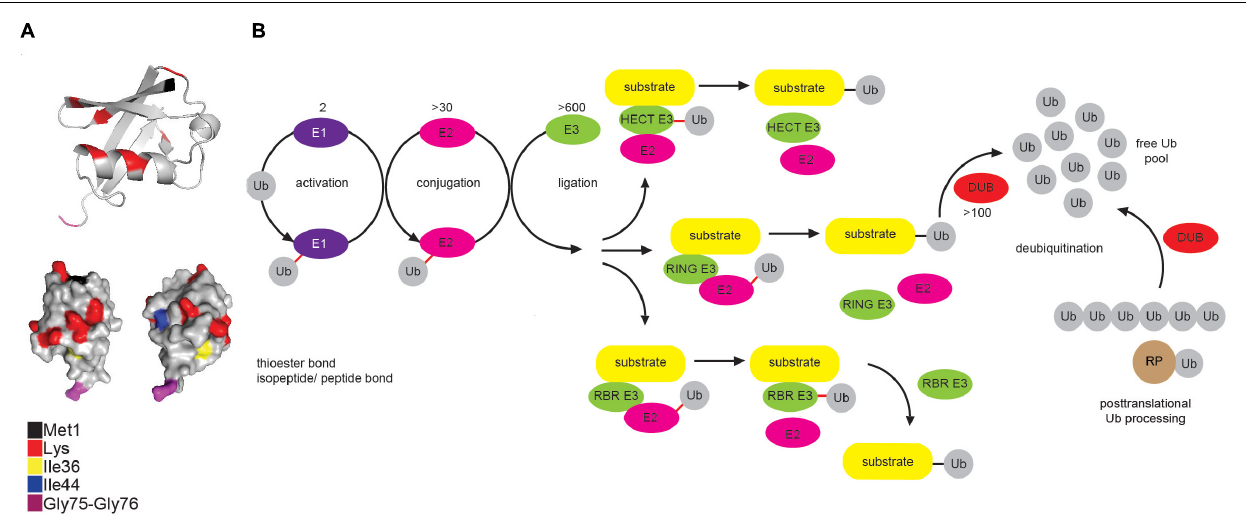
FIGURE 1 | Multicomponent enzymatic machineries assemble and disassemble ubiquitin modification. (A) Ub belongs to the β -grasp fold ( β -GF) family (Vijay-Kumar et al., 1987), in which β -GF is formed by five-stranded β -sheet, a short 3 10 helix and a 3.5-turn α -helix. The C-terminal Ub tail is essential for Ub conjugation and hence, for all the Ub functions. Functionally relevant Ub residues are depicted in different colors. The figure was generated from the PDB entry 1UBQ by PyMOL v1.7.6.0 software. (B) Coordinated activity of Ub-activating (E1), Ub-conjugating (E2), and Ub-ligating enzyme (E3) is required for Ub attachment to substrate protein. The action modes of the three main groups of E3 ligases (RING, HECT and RBR) are also depicted. In mammals, Ub is encoded by four different genes: UBA52 and RPS27A genes encode a single Ub molecule fused to the ribosomal subunits L40 and S27a, respectively (depicted as RP-Ub), UBB and UBC genes encode 2 different polyUb precursor proteins (exemplified here as Ub 6 fusion). More than 100 cellular DUBs process newly translated Ub-containing polypeptides, remove Ub from modified substrates and disassemble unanchored Ub